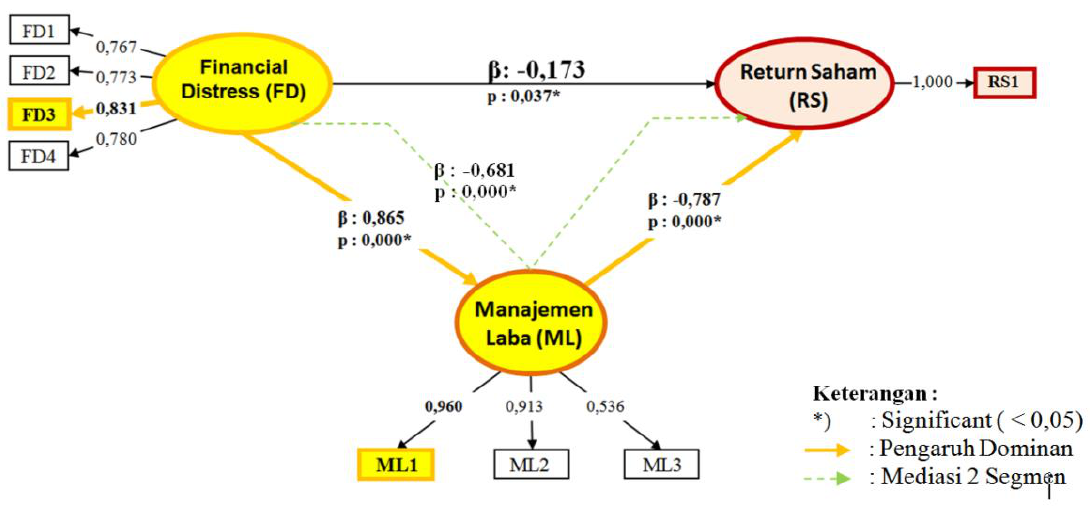
Figure 5: Path Diagram SEM-PLS OverAll Model 2